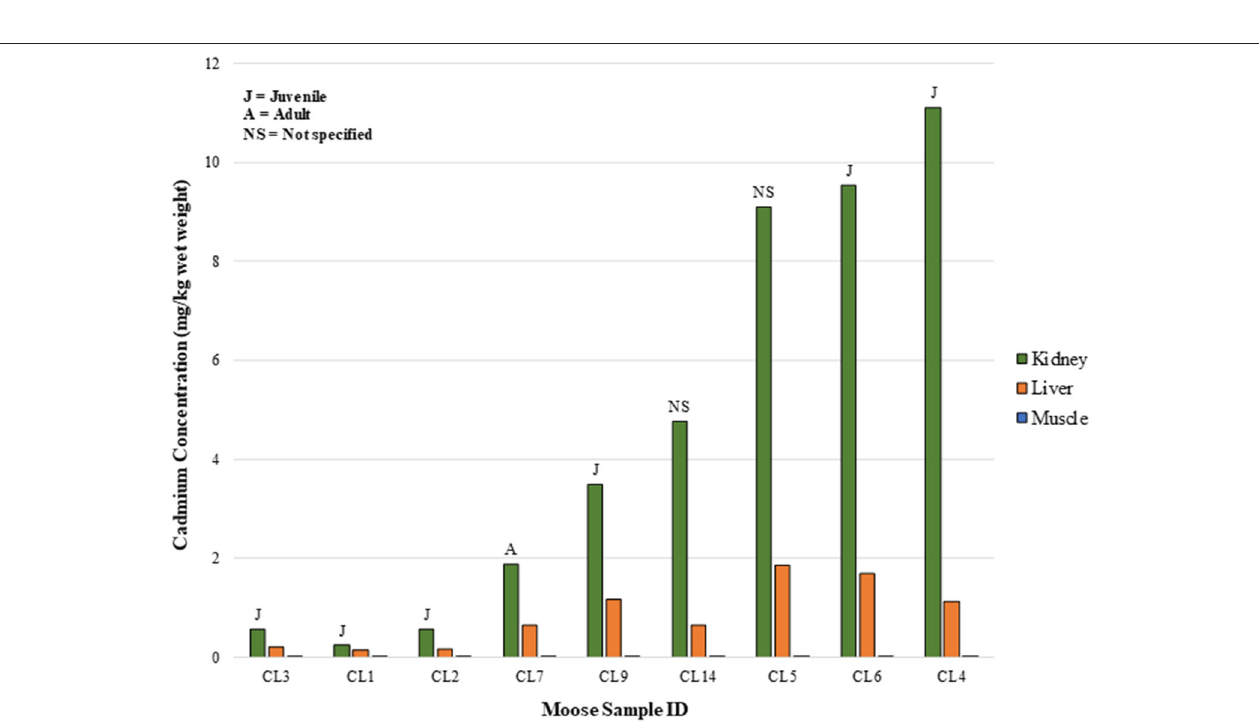
FIGURE 5 | Moose tissue concentrations -